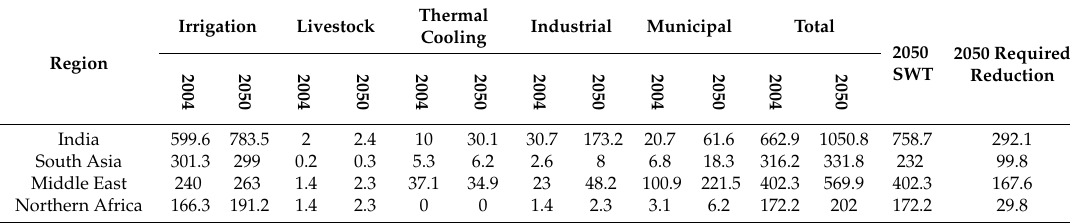
Table 1. Unconstrained water demand evolution and sustainable withdrawal thresholds (in km 3 ). Thermal Irrigation Livestock Industrial Municipal Cooling Region